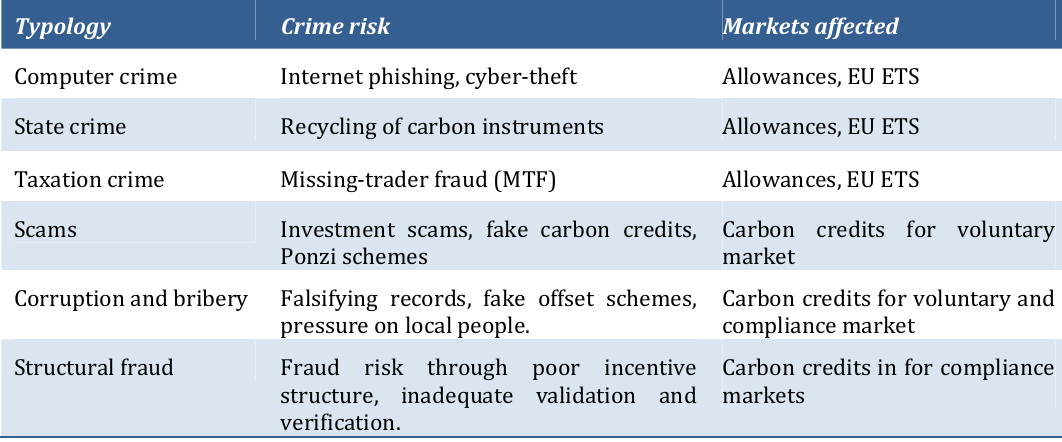
Table 1: Typologies of carbon crimes Typology Crime risk Markets affected Computer crime Internet phishing, cyber‐theft Allowances, EU ETS State crime Recycling of carbon instruments Allowances, EU ETS Taxation crime Missing‐trader fraud (MTF) Allowances, EU ETS Scams Investment scams, fake carbon credits, Carbon credits for voluntary Ponzi schemes market Corruption and bribery Falsifying records, fake offset schemes, Carbon credits for voluntary and pressure on local people. compliance market Structural fraud Fraud risk through poor incentive structure, inadequate validation and